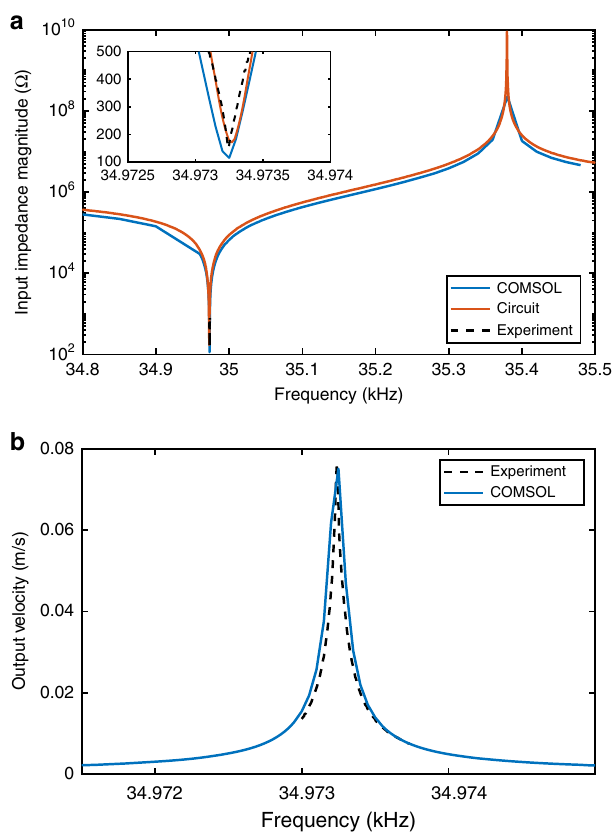
Fig. 3 Comparison of COMSOL model, equivalent circuit model, and experimental measurements. The experimental data is shifted down in frequency by 594.8 Hz to directly compare to the simulations. a The input impedance magnitude is compared for all three data sets, b for the COMSOL modal used in a , the output velocity is compared to